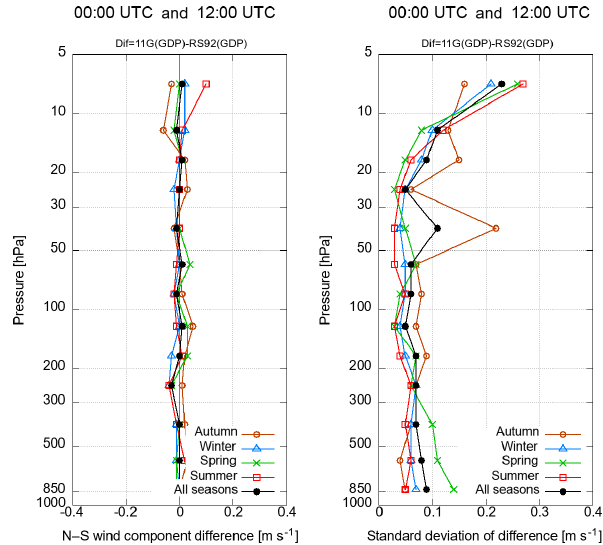
Figure 17. Profiles of differences and standard deviation, as for Fig. 10, but for wind speed for all soundings (00:00 and 12:00UTC combined).